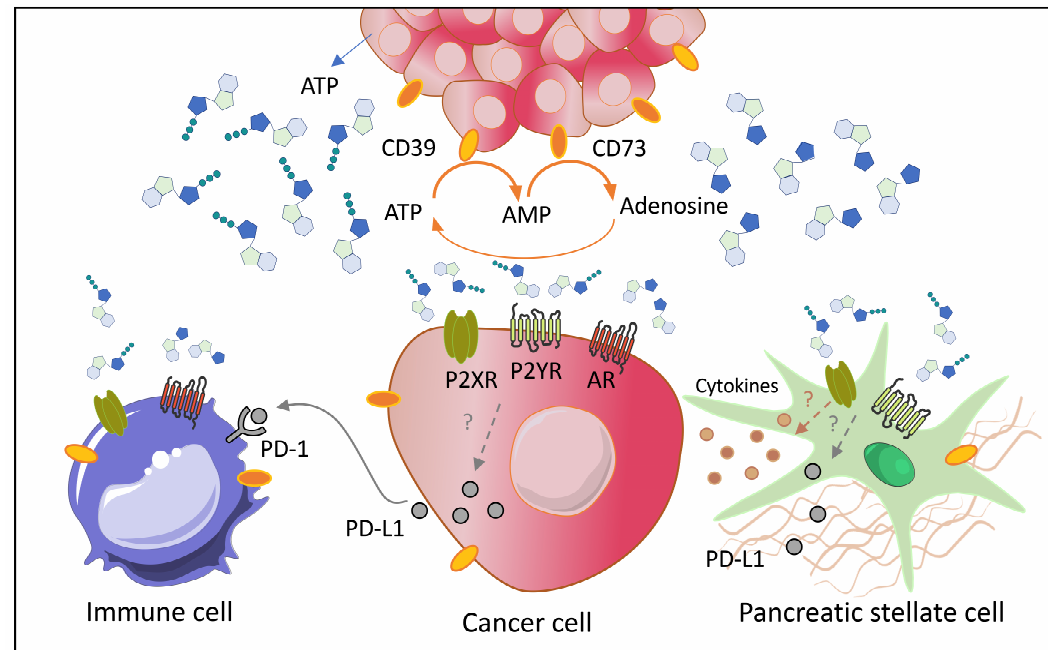
Figure 1. Schematic diagram of pancreatic tumor (upper part) and the key cells in the tumor microenvironment (TME) (detailed in the lower part)—cancer cells, pancreatic stellate cells (PSCs), and immune cells and key proteins in the purinergic network that are highly expressed in pancreatic ductal adenocarcinoma (PDAC). Cancer cells, and epithelial precursors (duct and acinar cells, see the abstract figure), have both several mechanisms to release ATP, which is then hydrolyzed via CD39 and CD73 to adenosine. In pancreas / PDAC, extracellular ATP stimulates P2 receptors, such as the P2X7, P2Y 2 , and P2Y 12 , while extracellular adenosine stimulates A 2A and A 2B receptors. PSCs secrete cytokines and extracellular matrix (ECM) proteins, express P2X7 and several P2Y receptors (see text). Immune cells express various P2X, P2Y, and A receptors (schematic). The model also shows programmed cells death protein-1 ligand (PD-L1) that is secreted by cancer cells and PSCs and binds to PD-1 receptor on T cells (and other immune cells). This constitutes the signaling network in TME by which the tumor may evade antigen-specific immunological response. Whether purinergic signaling regulates cytokine release or secretion of PD-L1 in PDAC is not known (indicated by?). Drugs or antibodies targeting one or more components of the purinergic / adenosinergic / PD-1 signaling are in some clinical trials for PDAC (Table